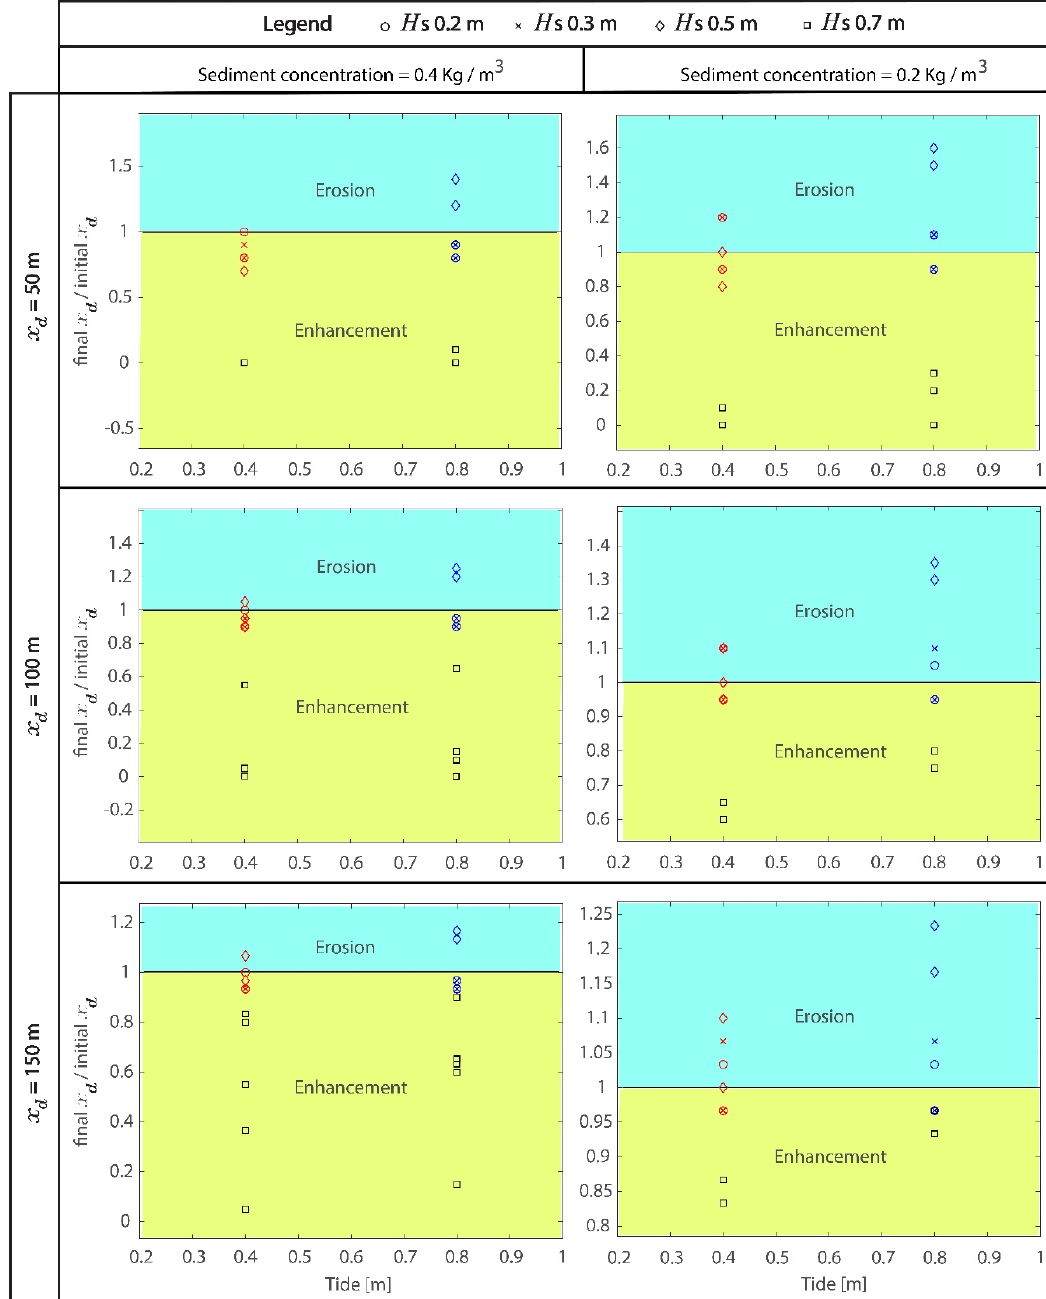
Figure 7. Ratio between the breakwater distance to the shoreline as function of the tide. The increasing of tide and breakwater distance to the coast increase the erosion at the marsh boundary, except for wave heights equal to 0.7 m, which mainly results in deposition into the marsh. The eroded volume of the marsh scarp from model configurations found to cause erosion (see Figure 7), as function of the dimensionless variable x d * Tide/ H s 2 , for the two different slopes and tides, is summarized in Figure 8. A linear correlation between the dimensionless variable and the eroded volume for the slope = 0.4% and tide = ±0.2 m (Figure 8a), slope = 0.4% and tide = ±0.4 m (Figure 8c). Another linear correlation between the dimensionless variable and the eroded volume for the slope